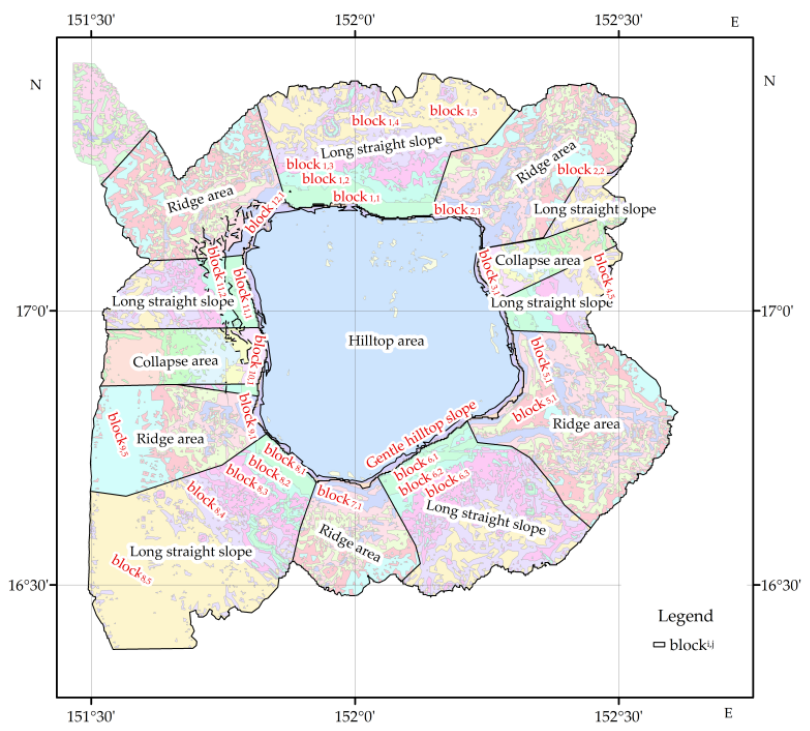
Figure 14. Mineralized block phase classification and statistical unit assignment.